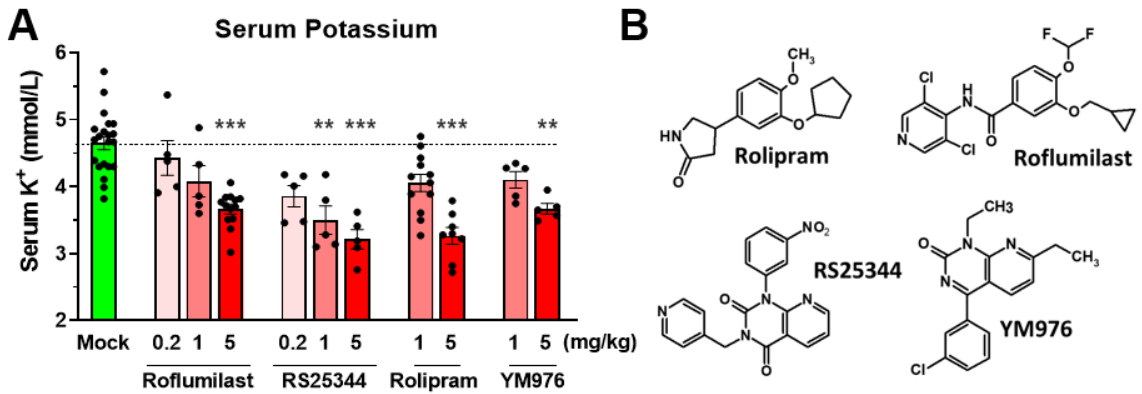
Figure 2. Reducing serum potassium is a class effect of PAN-PDE4 inhibitors. ( A ) Shown are serum potassium levels in mice treated with the indicated doses of the PAN-PDE4 inhibitors Roflumilast, RS25344, Rolipram, and YM976 (0.2, 1, or 5 mg/kg; i.p.) or solvent controls (Mock). ( B ) The chemical structures of the PDE4 inhibitors are shown for comparison. Data represent the mean ± SEM. Statistical significance was determined using Kruskal–Wallis followed by Dunn’s post hoc tests and is indicated as ** ( p < 0.01), and *** ( p < 0.001).